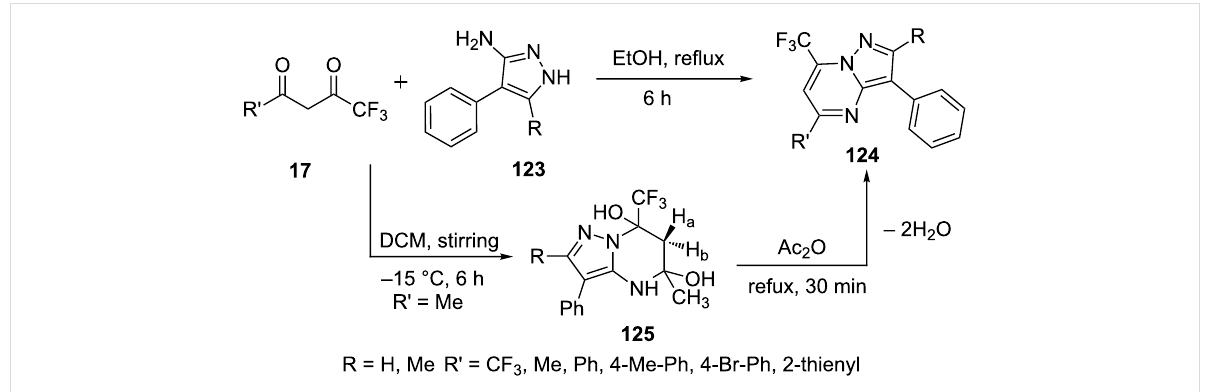
Scheme 34: Regioselective synthesis of 7-trifluoromethylpyrazolo[1,5- a